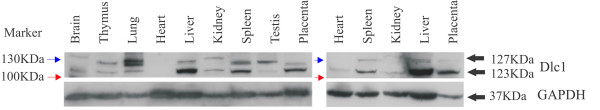
Dlc1 protein expression in different mouse tissues. Western blots of total cellular protein extracted from different mouse tissues using Dlc1 polyclonal antibody. The upper blot shows expression of Dlc1 related proteins and the lower blot shows the GAPDH loading control.